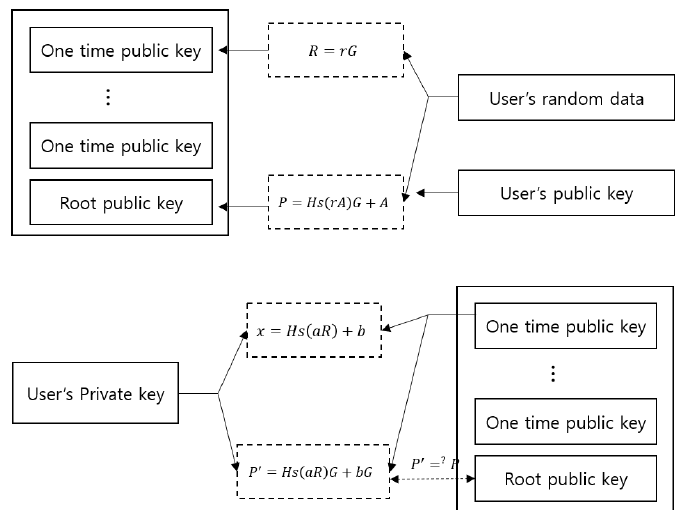
Figure 4. Generation and verification in a root signature